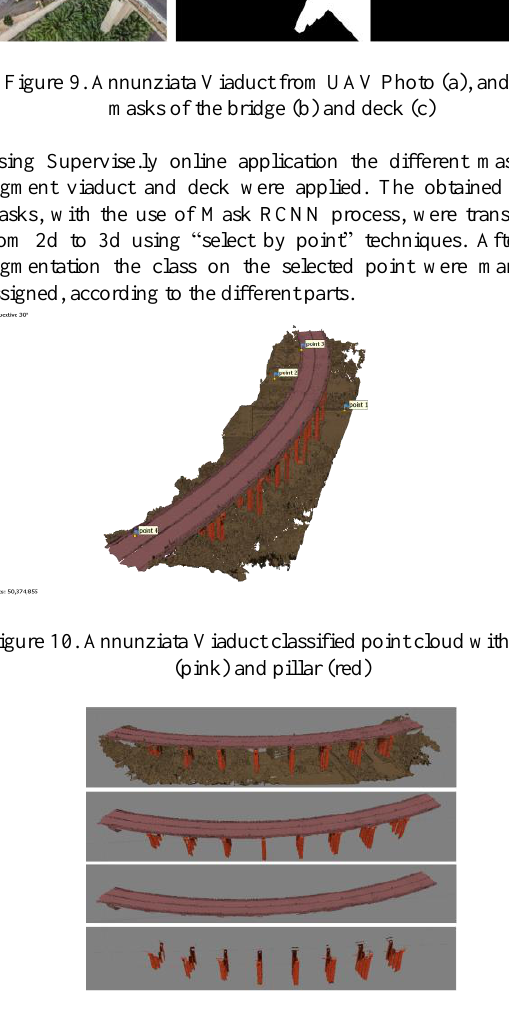
Figure 11. Annunziata Viaduct classified point cloud with deck and pillar